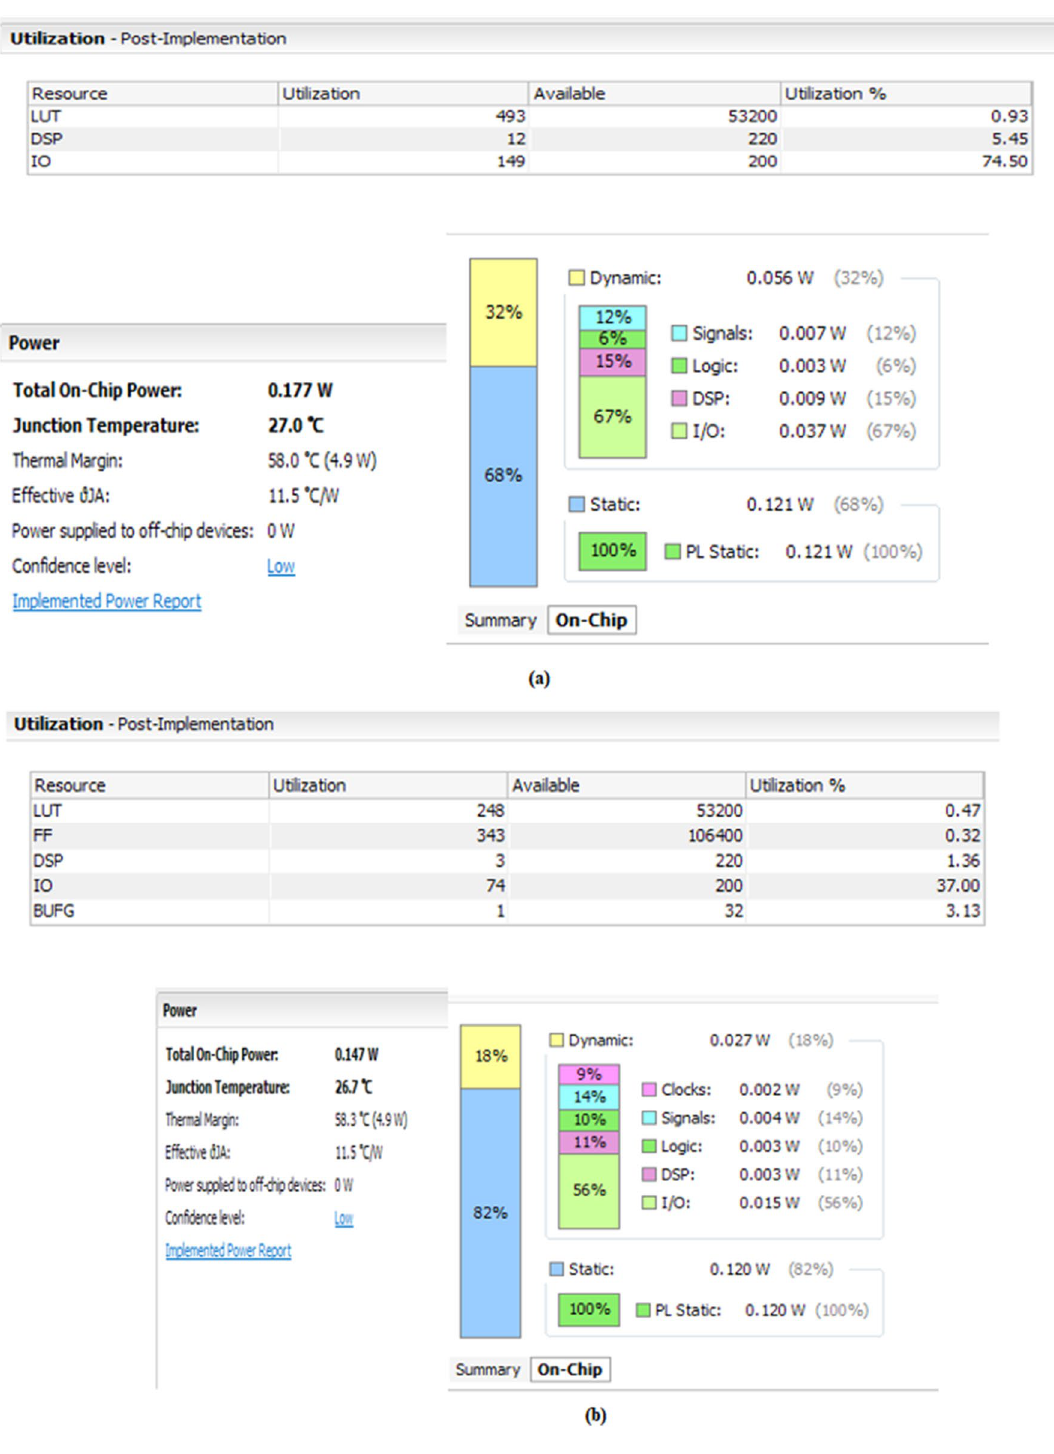
Figure 14. Synthesized results for folded GLRT block ( a ), conventional block ( b ) folded GLRT